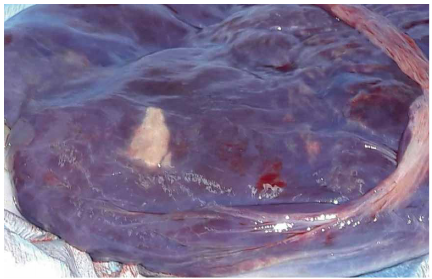
Figure 4: Formed bony tissue on the